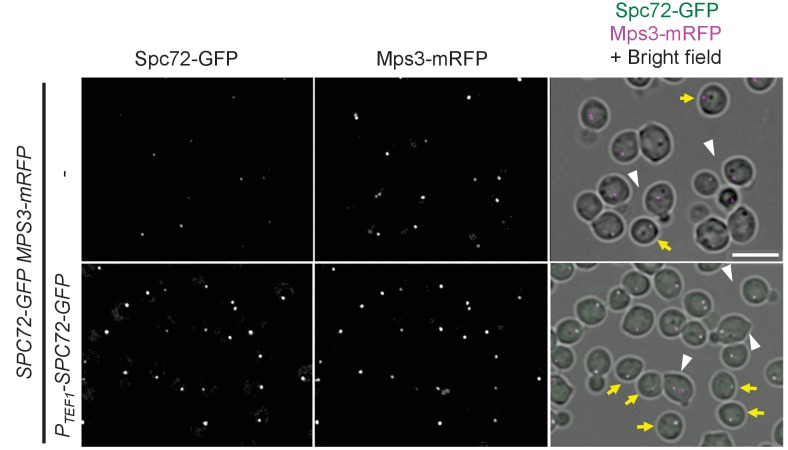
Spc72-GFP binds to SPBs in G1 and G1/S cells when overexpressed.Additional images of Figure 5F. Unbudded G1 cells and G1/S cells are indicated by yellow arrows and white arrowheads respectively. Scale bar, 5 µm.